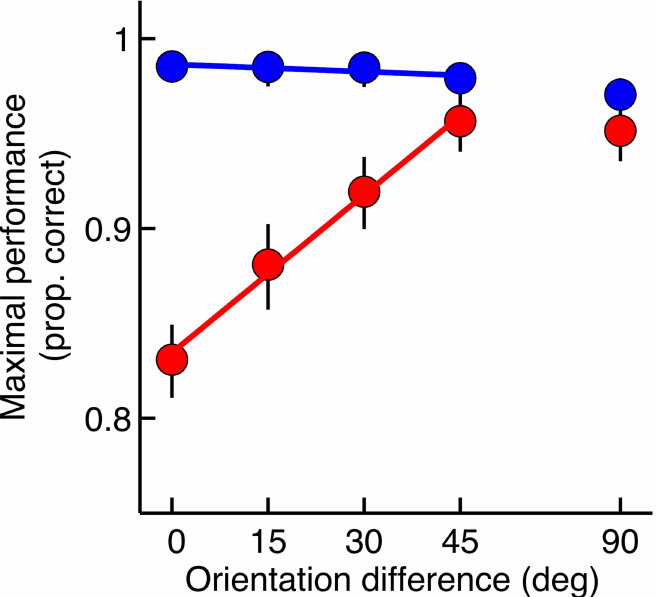
Fig 3. Dependence of maximal performance on orientation of the target grating. Full lines depict regressionlines reflecting maximal performance for orientationdifferences between target and inducers in the 0˚–45˚ range. Error bars denote the 95% confidence interval. When orientationdifference increasedfrom 0˚ to 45˚, maximal performance (1 − λ ) increasedsignificantly in the AM condition(red), while performance remained constant in the Flicker condition(blue). Maximal performance was not affected when increasing the orientationdifference from 45˚ to 90˚ in either the AM or Flicker condition.